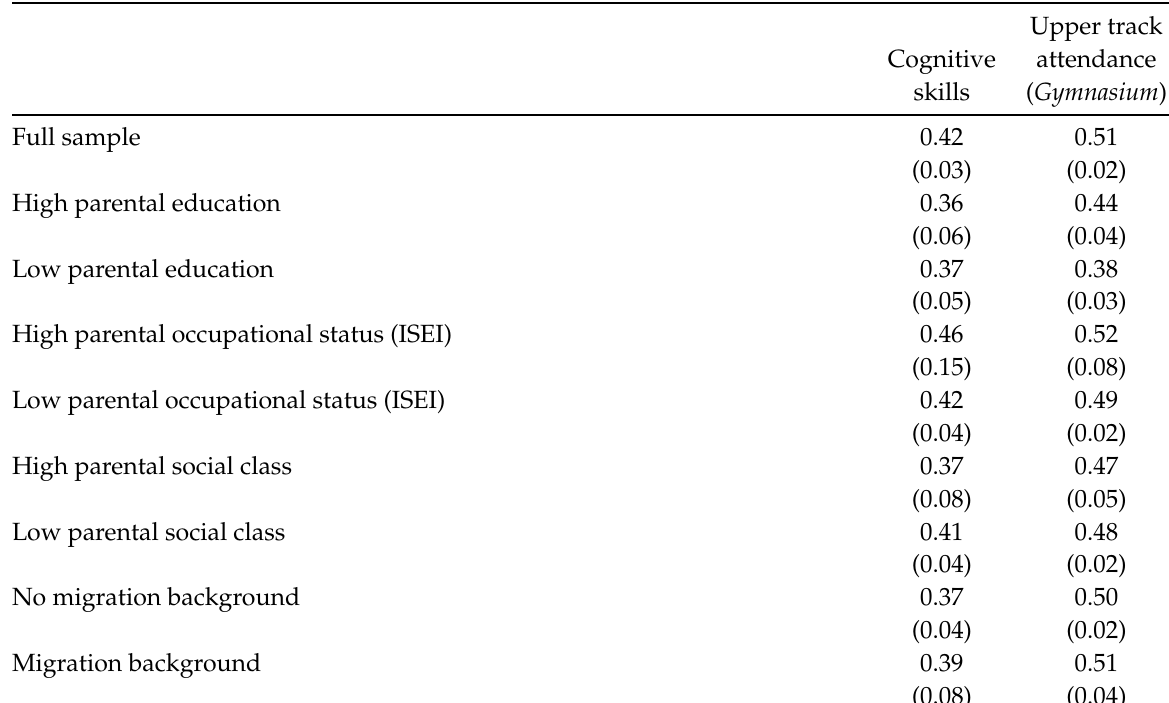
Table 2: Sibling correlations in educational